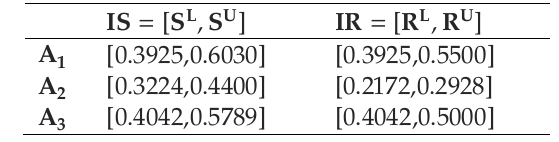
Table 3. IS and IR.